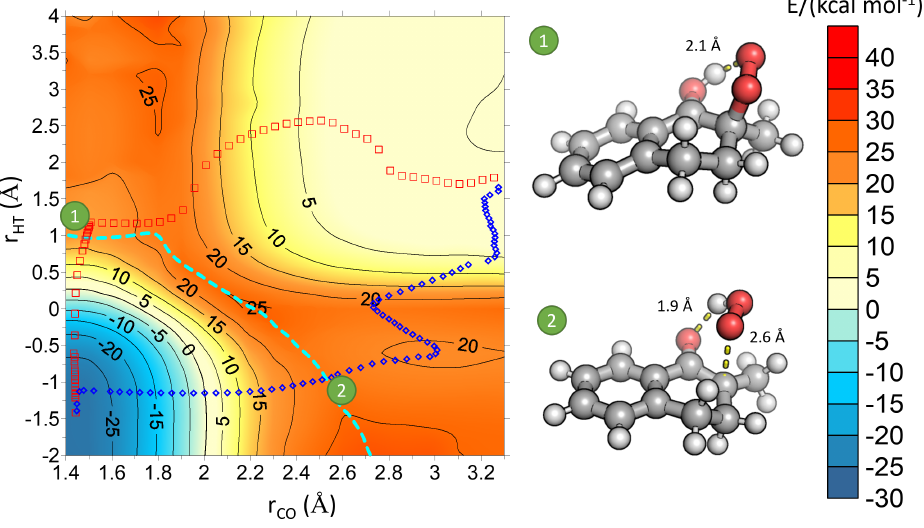
Figure 3. Representation of reaction paths over the 3D potential map, as a function of the energy minimum between the singlet and triplet states. Structures #1 and #2 correspond to the two MECPs obtained, and the red squares represent the geometries of the CO pathway, with the blue diamond showing the geometries of the OOH pathway. The cyan dashed line separates the region in which the singlet and the triplet are more stable. Energies are expressed in kcal/mol, following the color scheme shown in the scale, and distances are expressed in Å. Calculations were carried out at the M062X-D3/maug-cc-pVDZ level of theory. Cartesian coordinates corresponding to the two MECPs are shown in Table